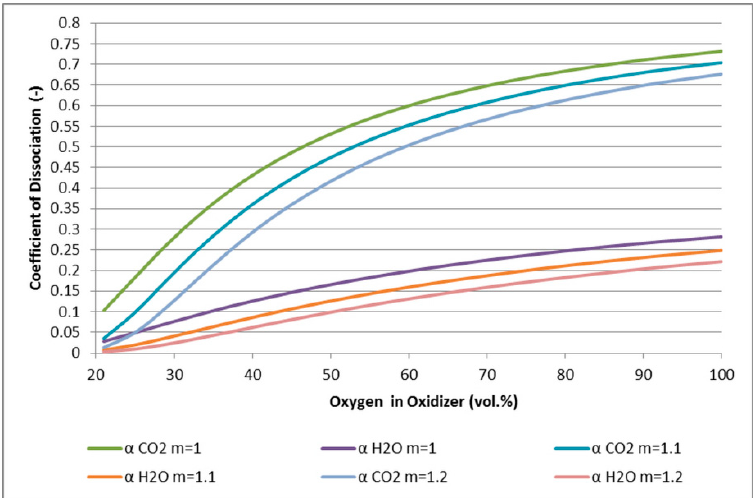
Figure 7. Dependence of coefficient of dissociation of CO 2 and H 2 O on oxidizer oxygen concentration (mathematical modeling).